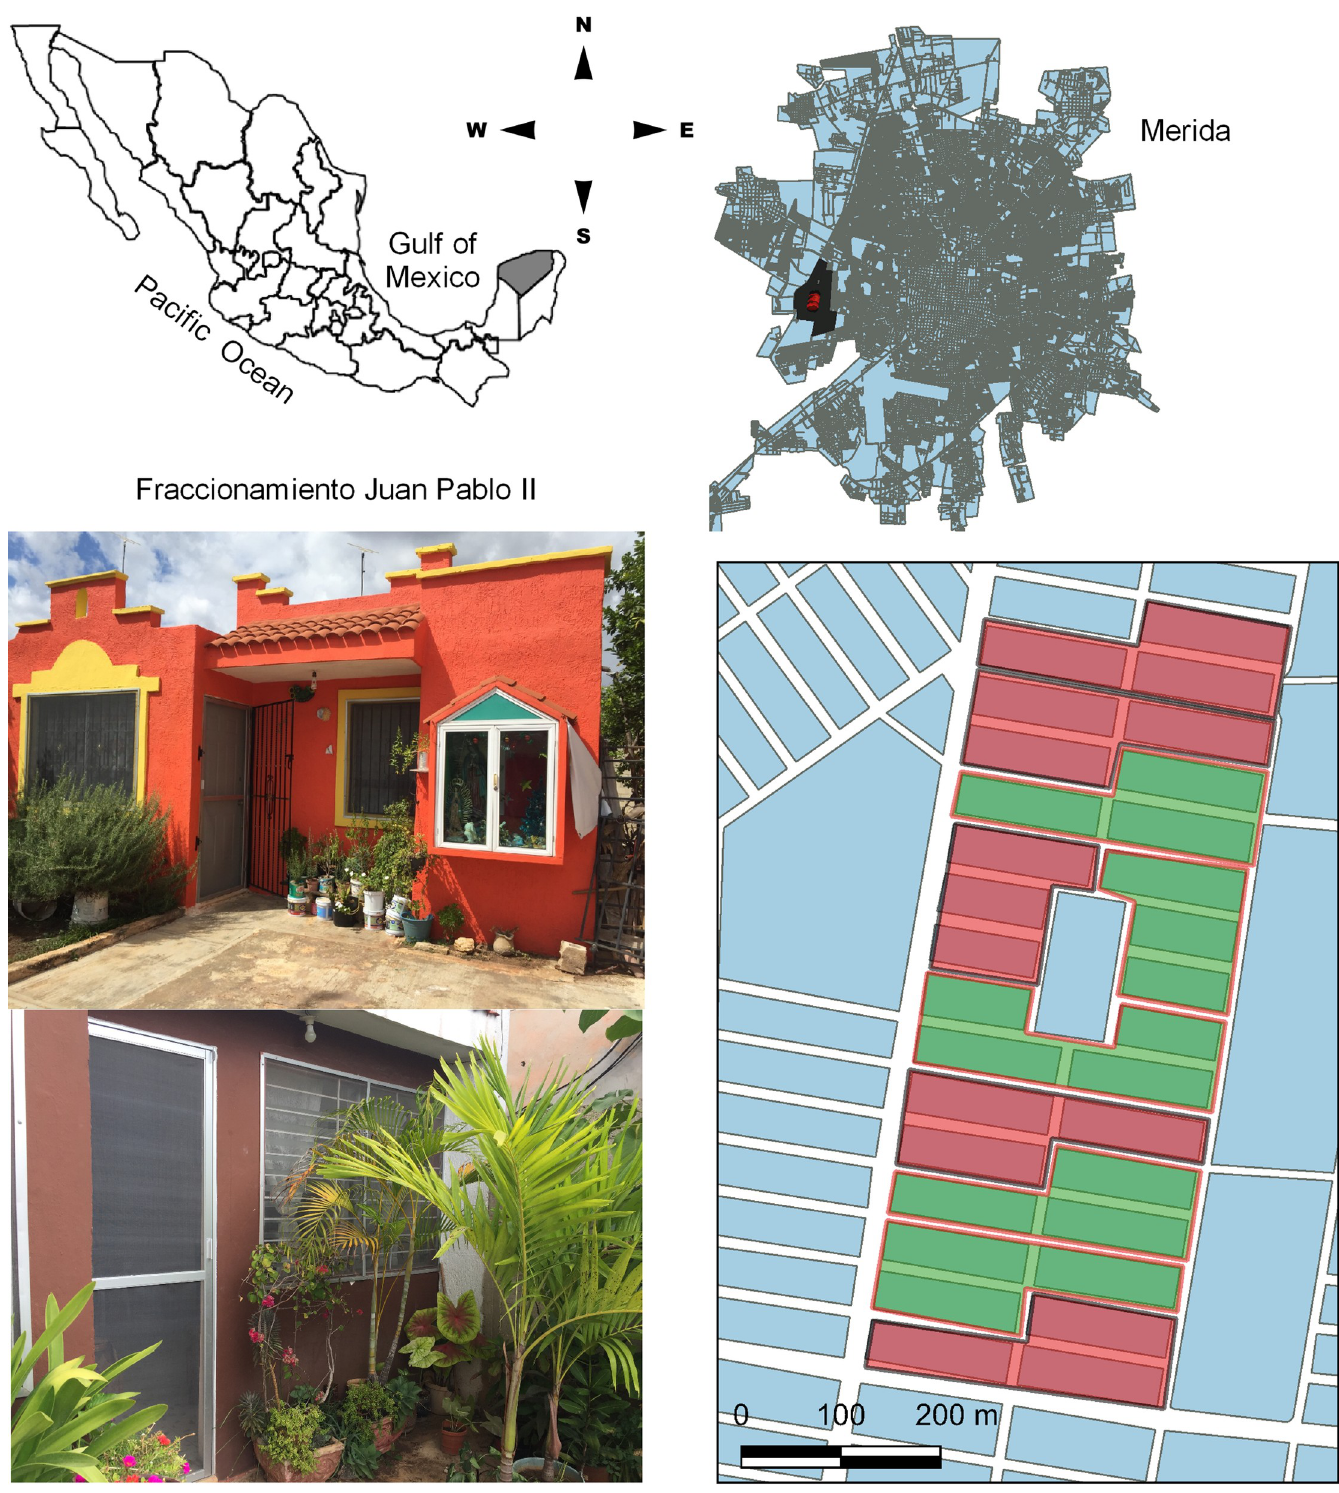
Fig 1. Study site. The city of Merida, Yucatan, Mexico and the location of the neighbourhood Juan Pablo II. Intervention clusters are shown in green and control clusters are coloured in red. Photographs show Aedes aegypti proof-houses with insecticide-treated screens mounted on aluminium frames and fixed to external doors and windows of treated